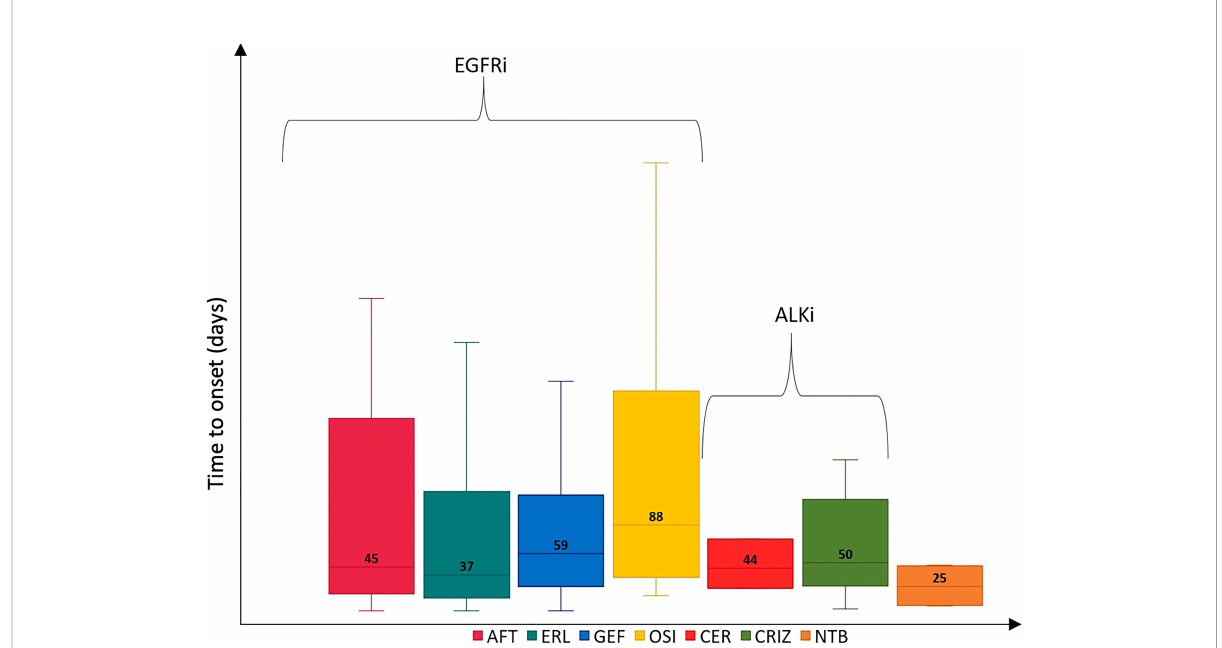
FIGURE 2 Time to onset of Sicilian ADRs related to TKIs approved for NSCLC. ADR, adverse drug reaction; AFT, afatinib; ALEC, alectinib; ALKi, anaplastic lymphoma kinase inhibitors; BRG, brigatinib; CER, ceritinib; CRIZ, crizotinib; EGFRi, epidermal growth factor receptor inhibitors; ERL, erlotinib; GEF, ge fi tinib; LORL, lorlatinib; NSCLC, non-small cell lung cancer; NTB, nintedanib; OSI, osimertinib; TKIs, tyrosine kinase